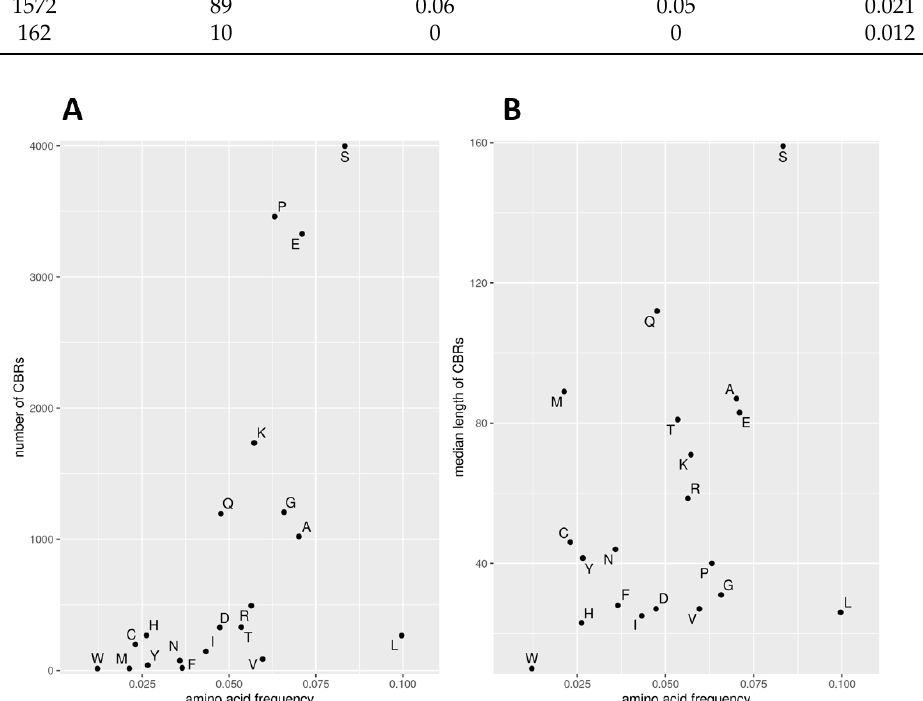
Figure 1. Properties of CBRs by type versus amino acid frequency. ( A ) Numbers of CBRs versus amino acid frequency. ( B ) Median CBR length (residues) versus amino acid frequency. Table 1. Properties of CBRs by type. Columns indicate type, number of CBRs, total of residues, median length, fraction of overlap to IDRs in numbers of regions and in residues, and general fre- quency of the amino acid in the human proteome (shown for comparison). Note that CBRs of dif- ferent types might overlap and thus the total number of residues in this table is higher than the number of residues in CBRs (2,597,987 and 2,215,396, respectively).